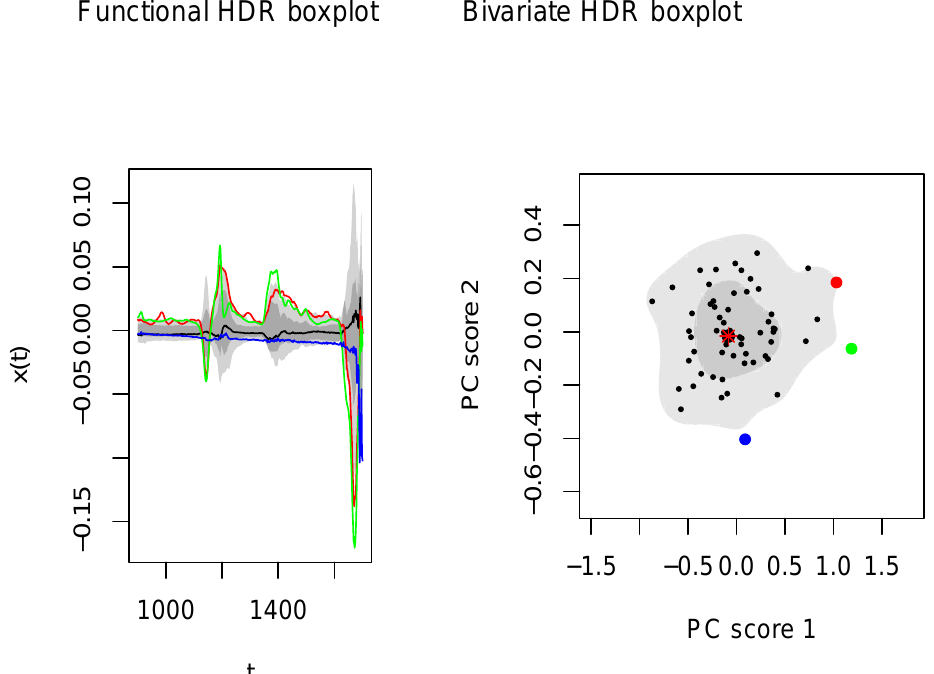
Figure A10. Upper row: Octane data. Lower row, left column: functional HDR boxplot; right column: bivariate HDR boxplot. Colored curves/points are outliers according to a coverage probability of 0.05 for the functional HDR boxplot. HDR boxplots computed with rainbow::fboxplot